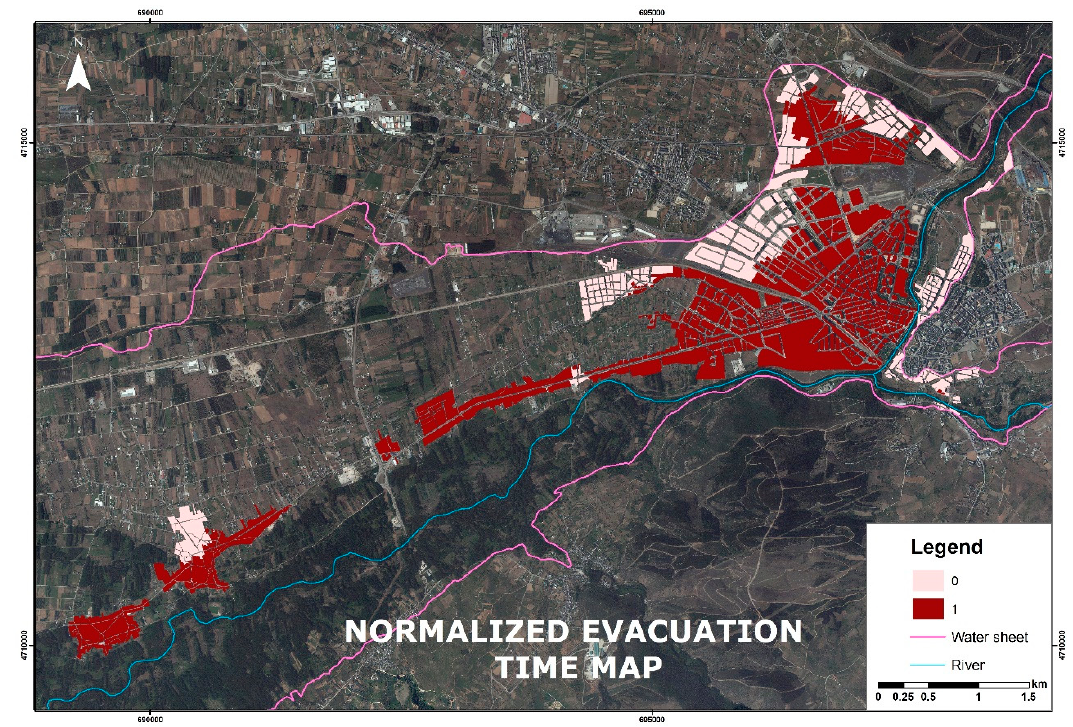
Figure 5. Normalized evacuation time map in Ponferrada.